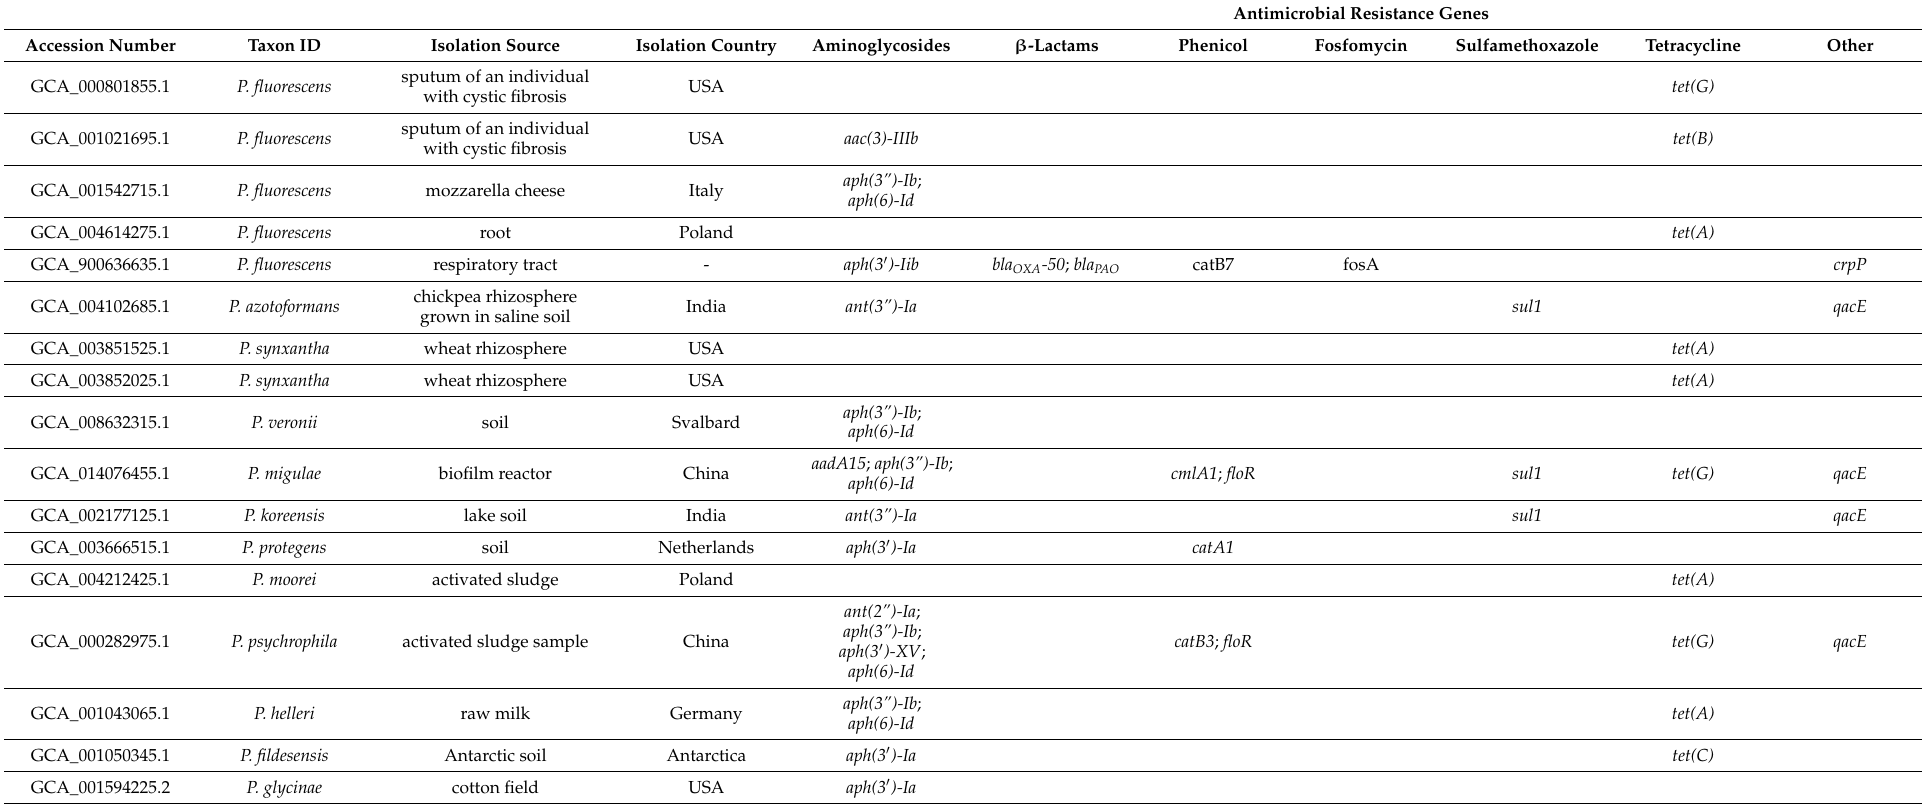
Table 3. P. fluorescens genomes harboring transferable antimicrobial resistance determinants.